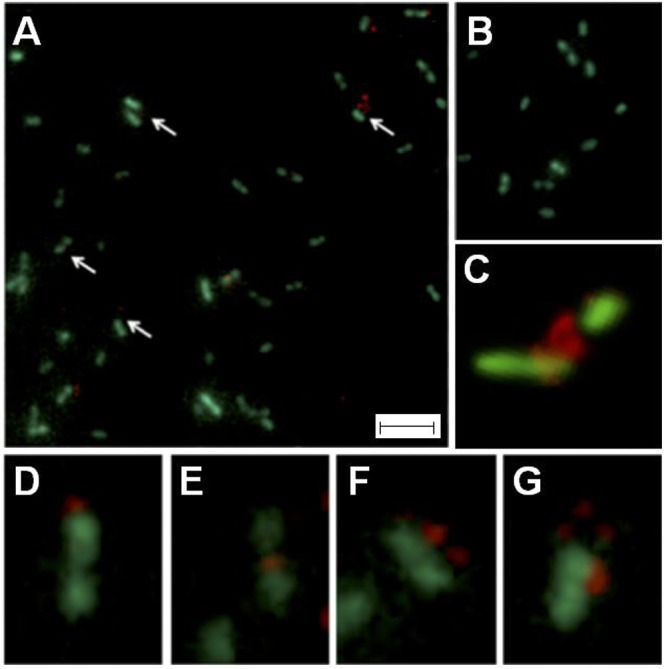
Visualization of pilus in A. ferrooxidansAfeGreen1 cells by epifluorescence microscopy. (A) Cells (green) incubated with anti-pilin serum. (B) Cells (green) incubated with pre-immune serum. (C) Confocal microscopy image showing pilin-specific mark (red) in the interface between two cells. Pilin-specific marks are indicated with white arrows. (C–G) Magnifications of field sections of (B). For (A,B) bar: 8 μm; for (C–G) bar: 2 μm.